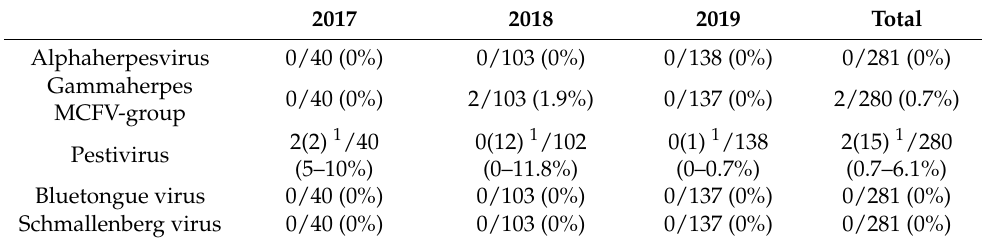
Table 3. Summary of results for each serological screening and year, indicating seropositive/tested (percentage).